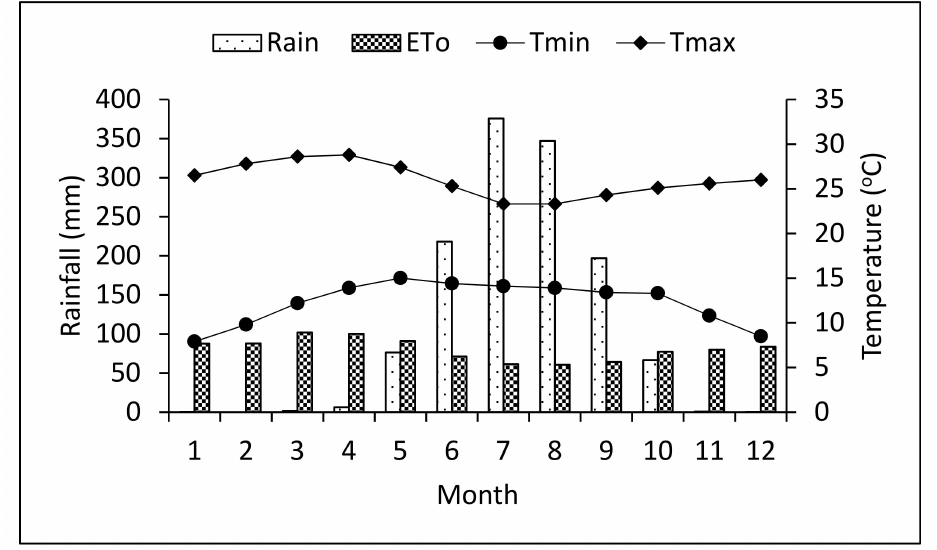
Figure 2. Mean monthly rainfall (RF, mm), reference evapotranspiration (ETo, mm) and temperature ( ◦ C) (NMSA, 1987–2019). In Koga, the farming system is a mixed crop-livestock system, where livestock pro- vides the draught power needed for the farming operation [18]. Maize, finger millet, and teff are mainly planted during the main rainy season, while wheat, maize, and vegetables are grown under irrigated conditions. The average landholding size is 1.2 ha. The land use system in KIS is mainly cultivated except for very few home gardens and eucalyptus woodlots found around roadsides. Furrow irrigation is a common practice in Koga